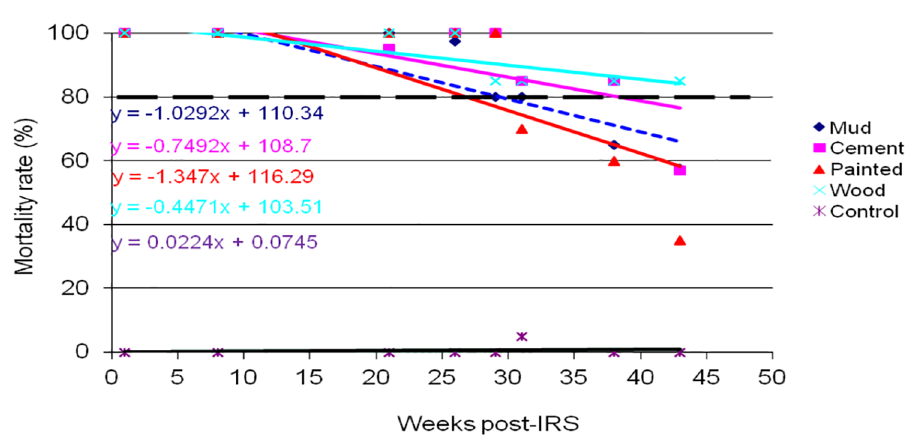
Fig 5. Cone wall bioassay response of susceptible strain An . gambiae s . s to p-methyl 300 CS sprayed in different wall surfacesin Natta-Mbisso village, Serengeti district. The dashed line represents the WHO thresholdof 80% mortality.